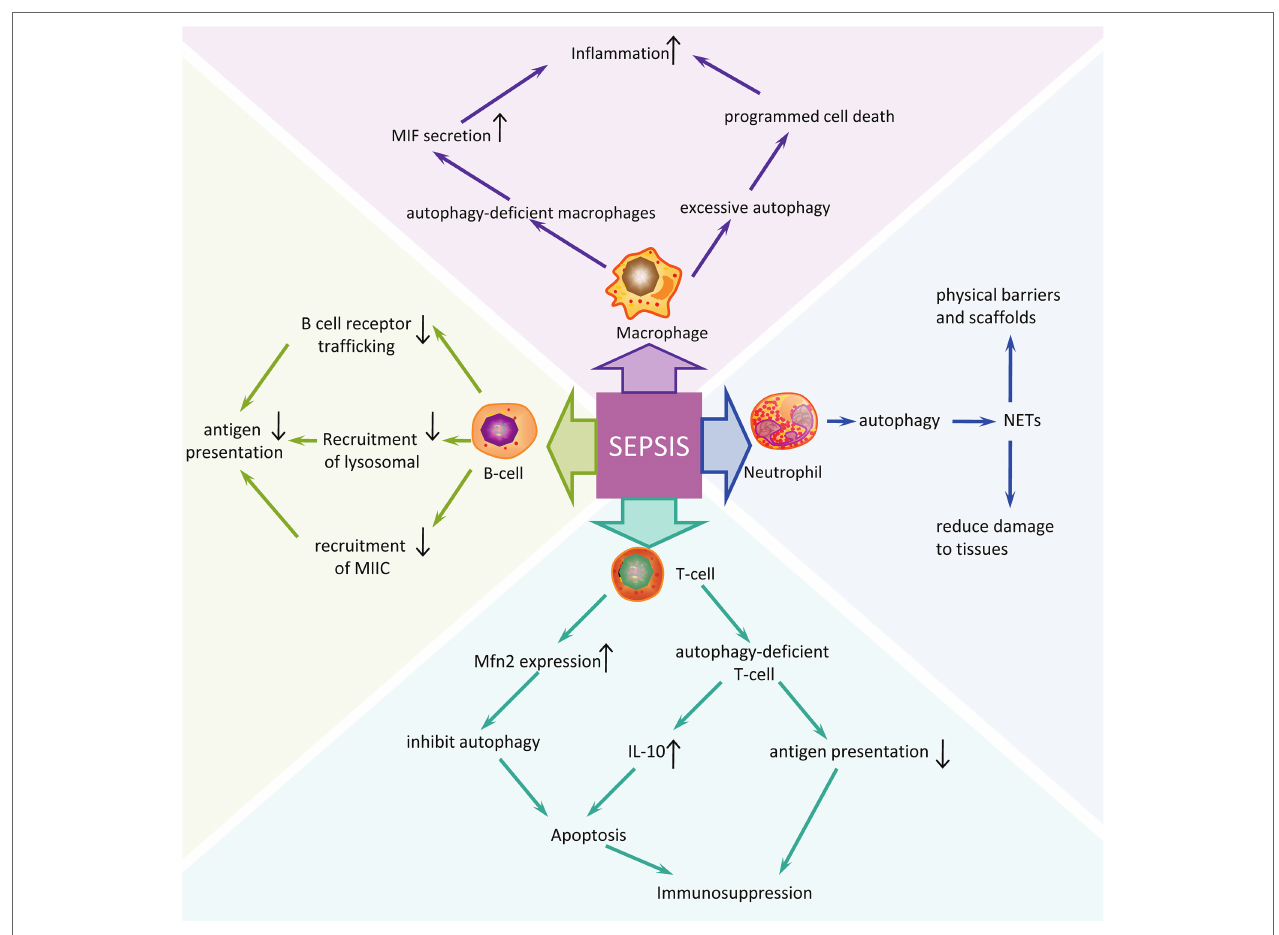
FIGURE 1 | Autophagy regulation mechanism of different immune cells in sepsis. An overview of many possible mechanisms in innate immune and acquired immune cells may contribute to the pathogenesis of sepsis. Sepsis is a very serious systemic infectious disease by which severity is closely related to the host’s immune function. The postulated mechanisms by which different immune cells respond to sepsis might contribute to the development of sepsis are based on studies in vitro and animal models. The induction of autophagy in sepsis often promotes the immune response process of immune cells; while inhibition of autophagy or autophagy defects aggravates the inflammatory response and immunosuppression of sepsis. NETs, neutrophil extracellular